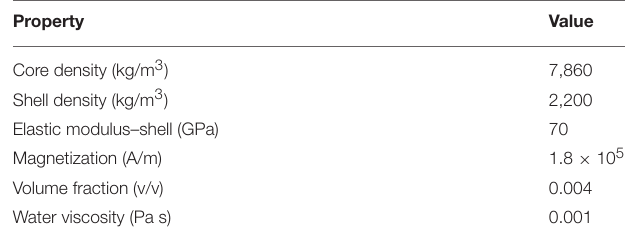
TABLE 1 | Particle physical properties and fluid